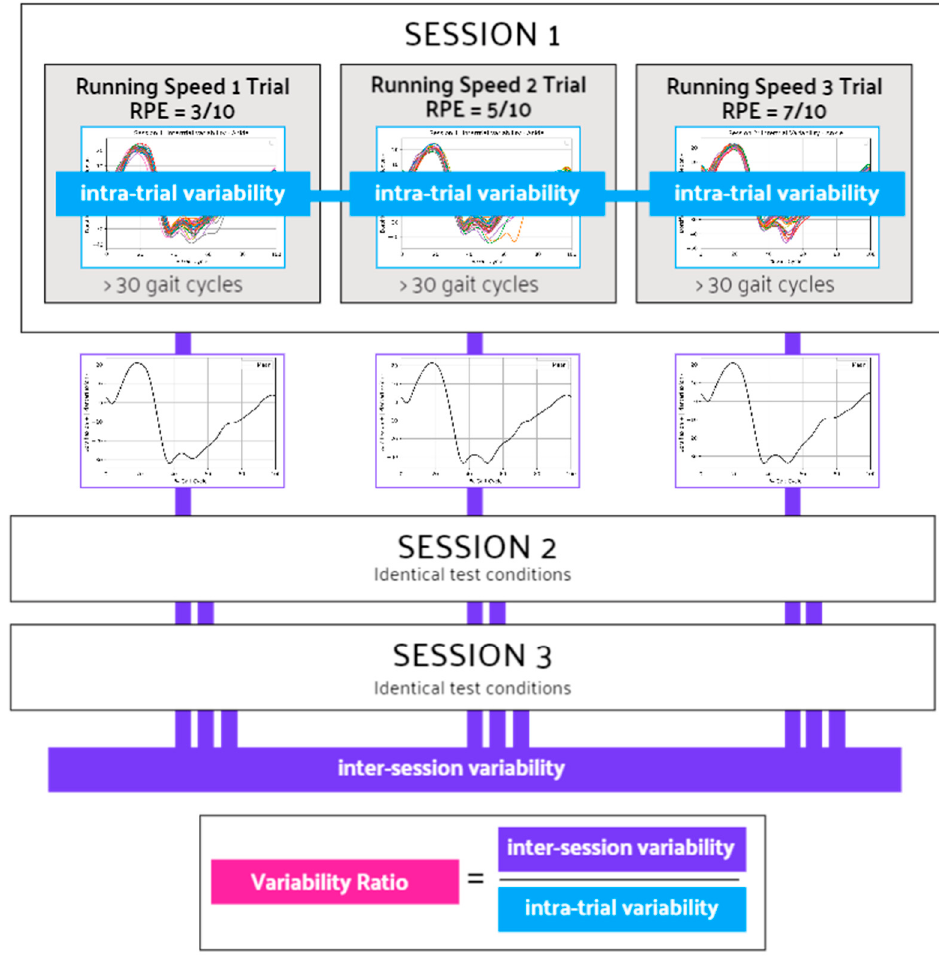
Figure 4. Intra-trial variability (n = 63) was computed as the average standard deviation over the entire gait cycle for each joint angle and then averaged across all participants (n = 21) and speeds (n = 3). Inter-session variability was computed as the average standard deviation over the entire gait cycle between the joint angle mean waveforms between the three sessions. The variability ratio was the ratio of inter-session to intra-trial variability.